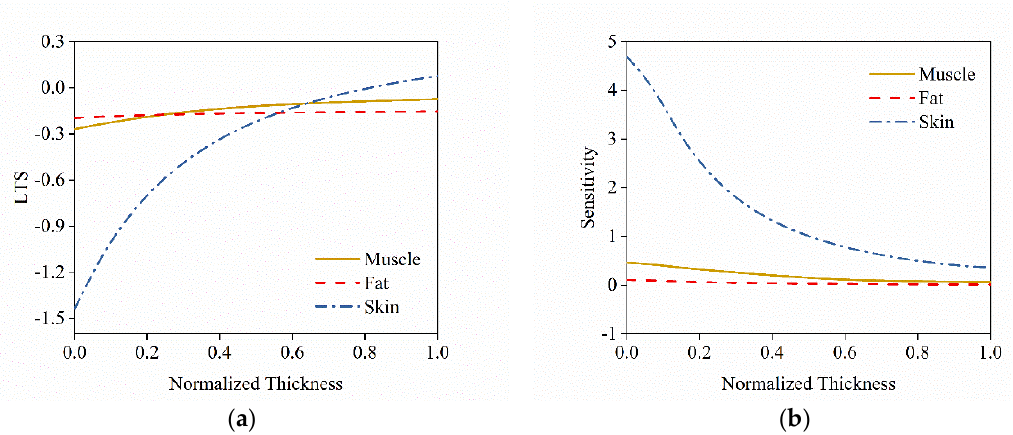
Figure 10. ( a )The variation of the thermal sensation index with tissue thickness change; ( b ) the sensitivity of the thermal sensation index to tissue thickness change. sensitivity of the thermal sensation index to tissue thickness